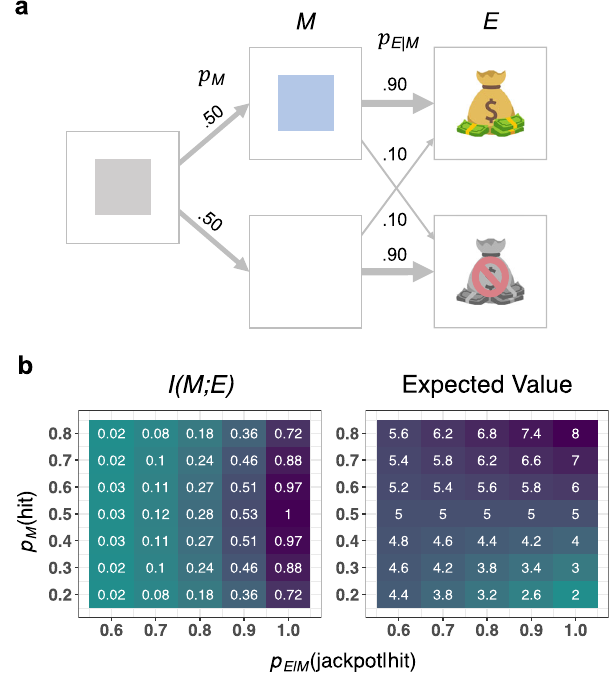
Fig. 1 Design and features of the tile game. a Schematic of the tile game for experiments 1 – 2. First, a gray tile appears on the screen, and the player must press the spacebar before it disappears. If successful, the tile changes color before transitioning to the jackpot or no jackpot state. We have illustrated the tile game with example values for p M hit ð Þ and p ð jackpot j hit Þ ; the full set of values are given in panel b. In this example, E j M there is a 50% chance of activating the tile, p M hit ð Þ ¼ : 5. If the tile is activated, there is a 90% chance of transitioning to the jackpot state, p E j M ð jackpot j hit Þ ¼ : 9, and a 10% chance of transitioning to the no jackpot state, p ð no jackpot j hit Þ ¼ : 1. If the tile is not activated, there is a 10% E j M chance of transitioning to the jackpot state, p E j M ð jackpot j miss Þ ¼ : 1, and a 90% chance of transitioning to the no jackpot state, p E j M ð no jackpot j miss Þ ¼ : 9. b Breakdown of I ð M ; E Þ , left, and average number of cents earned per trial (expected value), right, for different values of p M ð hit Þ and p E j M ð jackpot j hit Þ